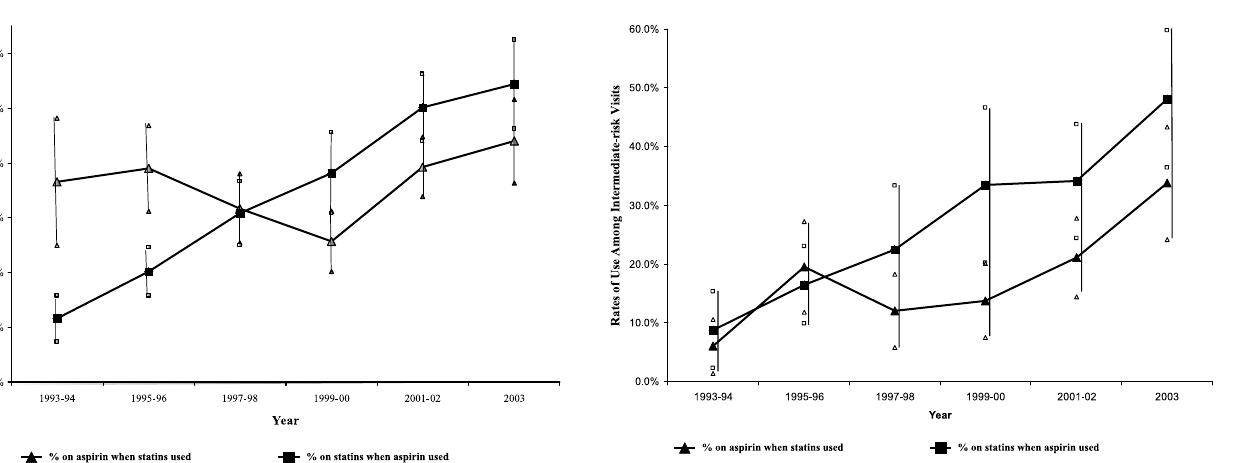
Figure 2. National Trends in Aspirin and Statin Use When the Other Therapy Is Present among High-Risk Patient Visits Vertical bars indicate 99% CIs. DOI: 10.1371/journal.pmed.0020353.g002